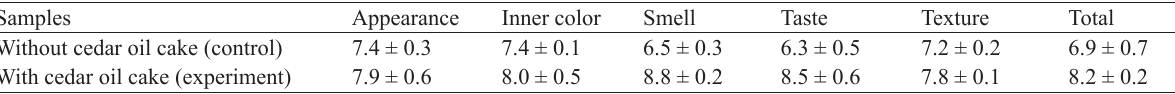
Table 5 Sensory evaluation of semi-smoked sausages Samples Appearance Inner color Smell Taste Texture Without cedar oil cake (control)